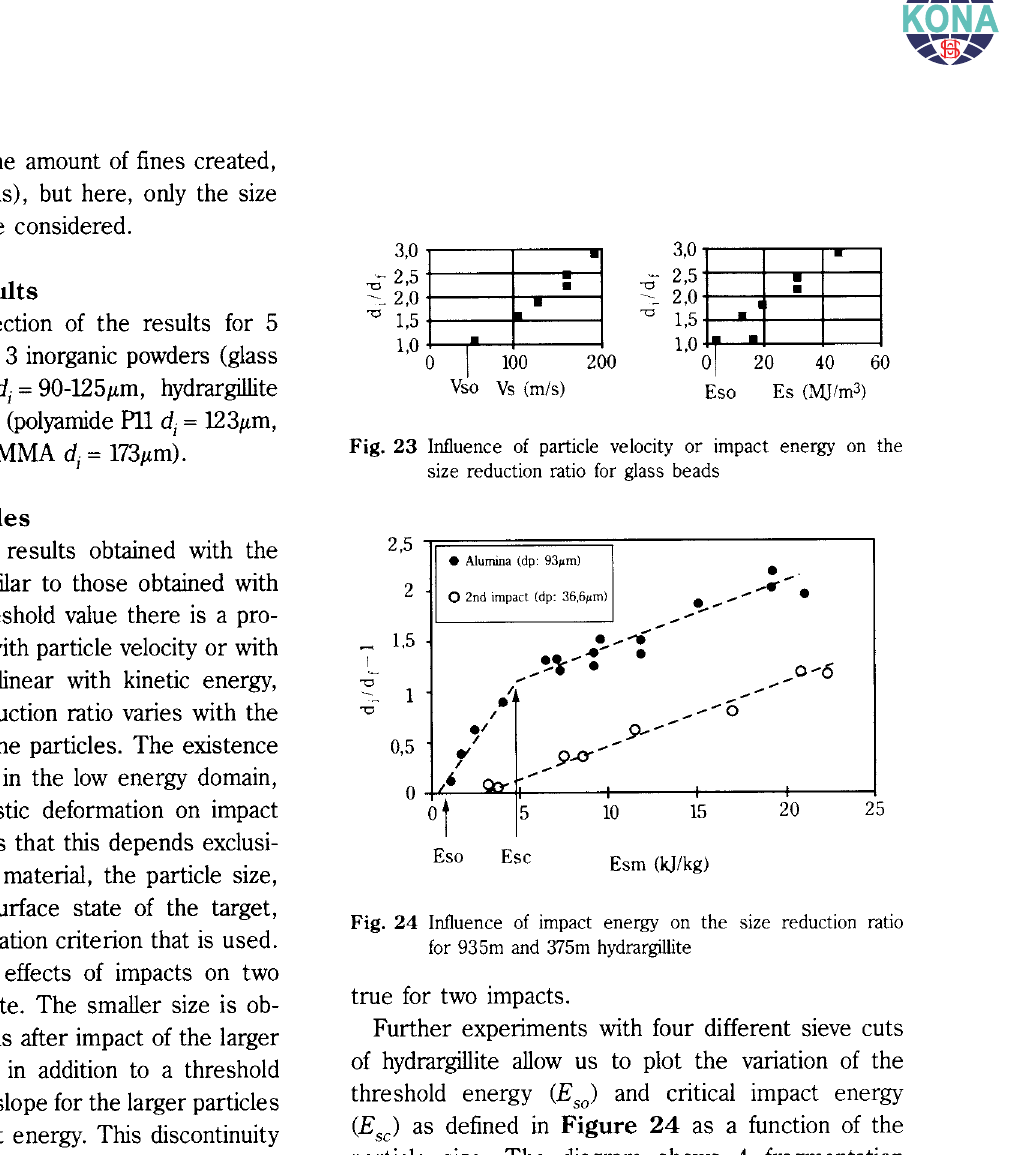
Fig. 24 Influence of impact energy on the size reduction ratio for 93 5m and 375m hydrargillite true for two impacts.